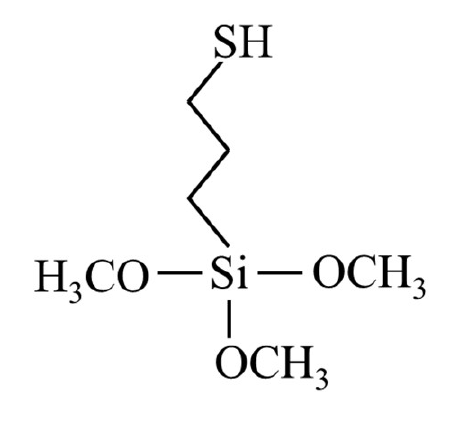
Figure 6. Chemical structure of MPTS.